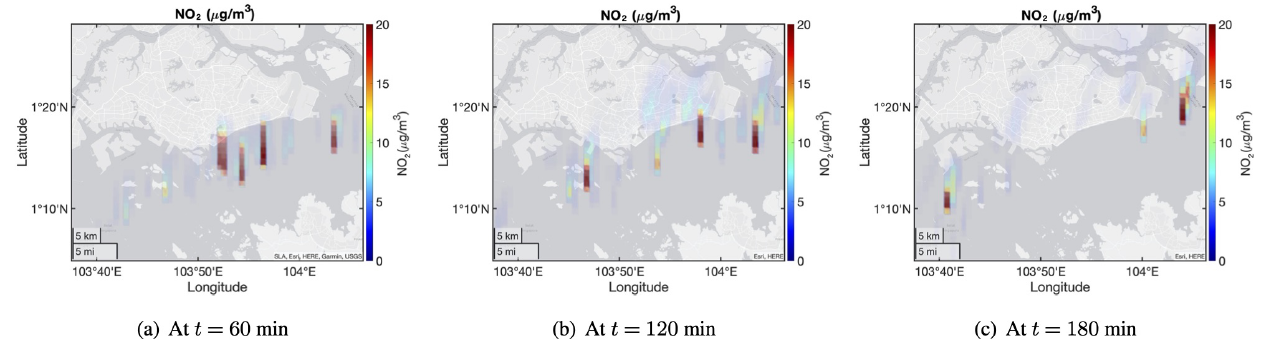
Figure 14. Instantaneous NO 2 concentrations near the ground by using the FPS model (case 3).